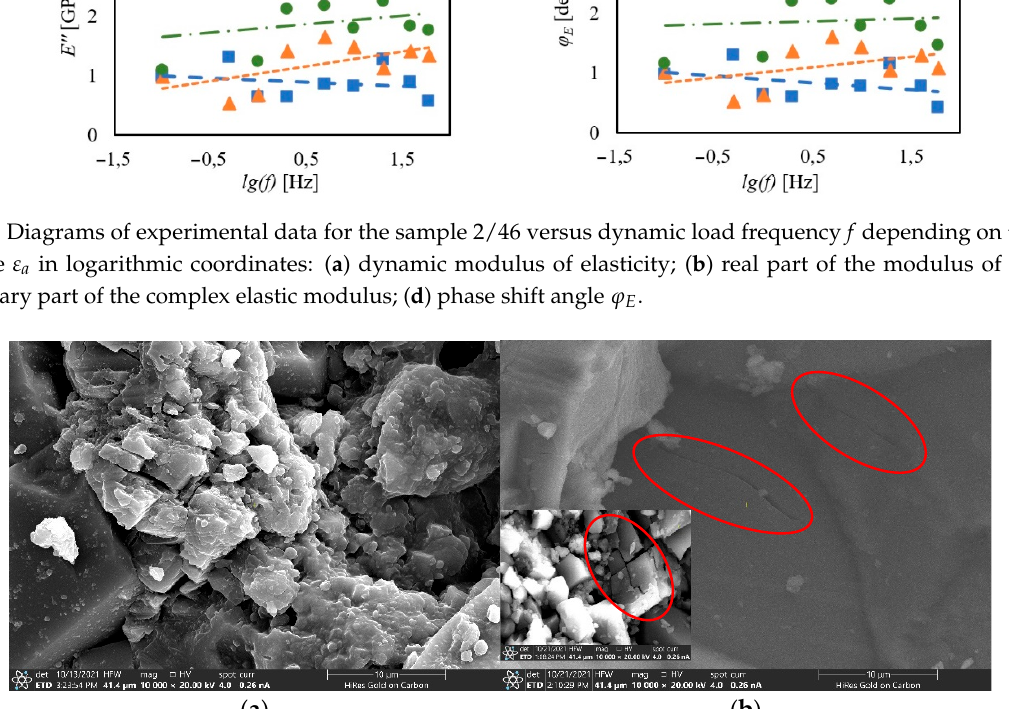
Figure 20. Pore space of limestone sample obtained with an electron microscope when analyzing sample 2/46 with magnification of 10 4 : ( a ) no cracks before the dynamic loading; ( b ) cracks in calcium crystals after dynamic loading.